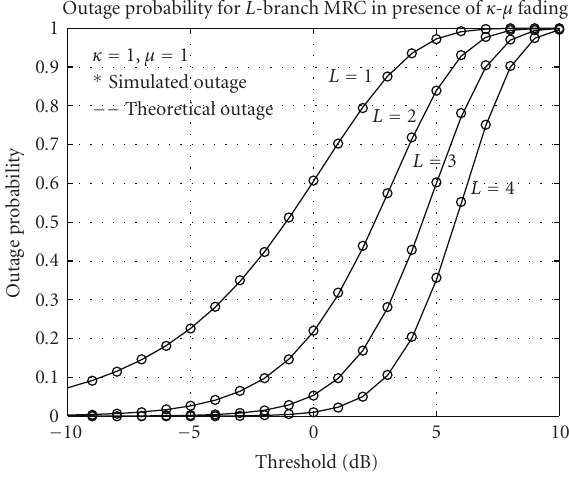
Figure 3: Outage probability for κ = 1 and μ = 1. Figure 4: Outage probability for κ = 1 and μ = 2. Outage probability for L -branch MRC in presence of κ - μ fading